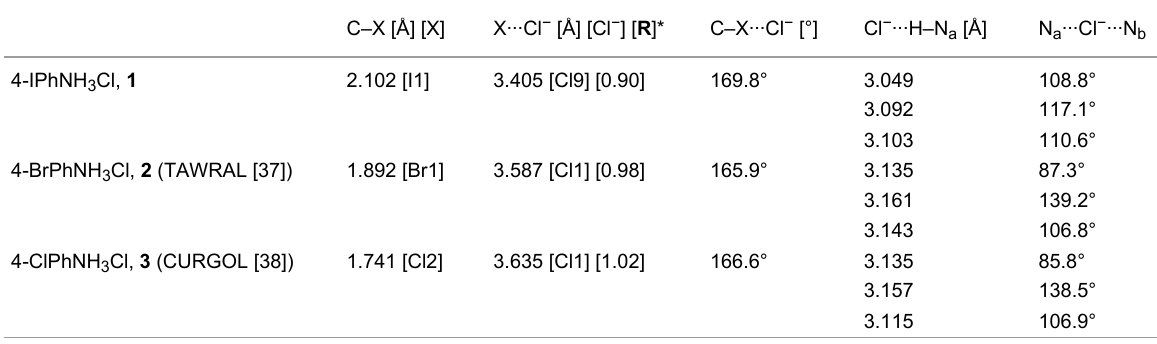
Table 1: Relevant C–X, hydrogen bond and halogen bond lengths and angles in 1 – 3